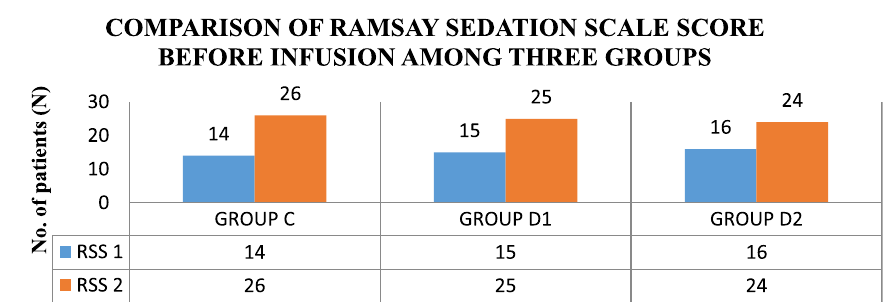
Fig. 6 Comparison of Ramsay Sedation Scale (RSS) score before infusion of study drug among three groups